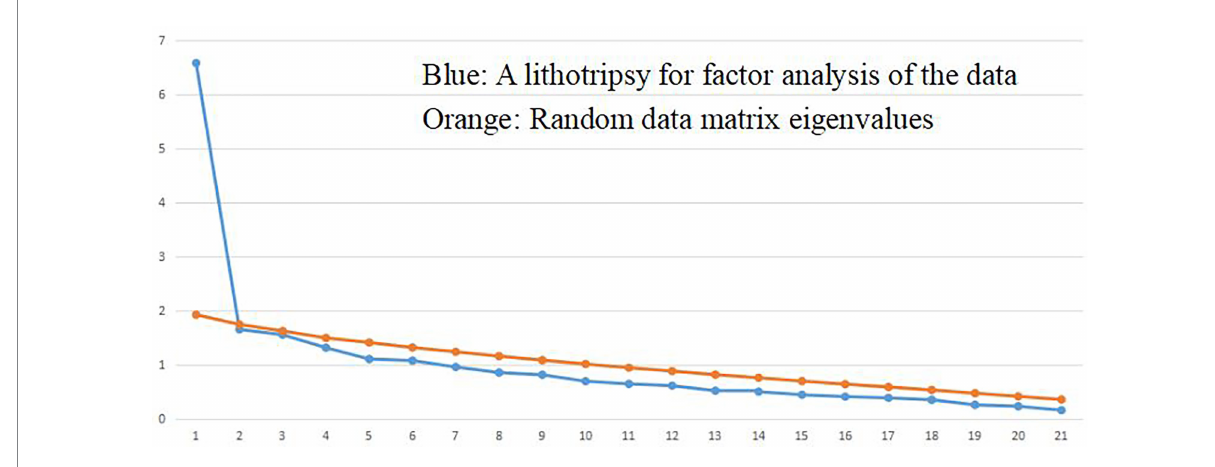
FIGURE 1 Exploratory factor analysis versus parallel analysis